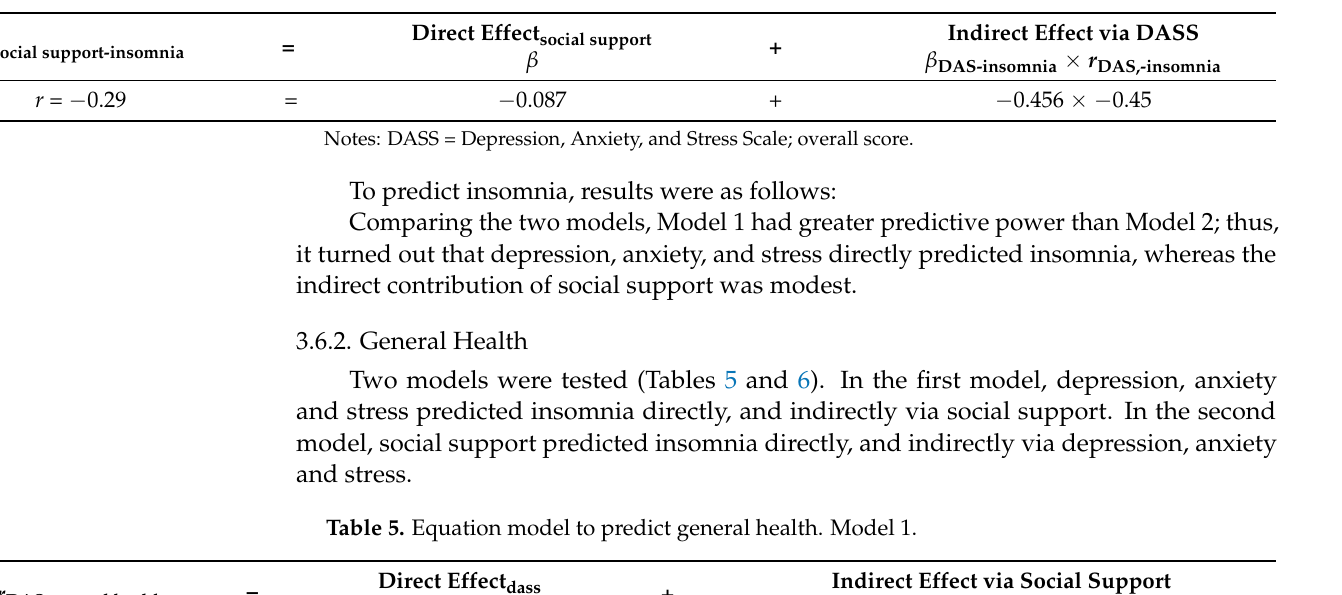
Table 4. Equation models to predict insomnia. Model 2.